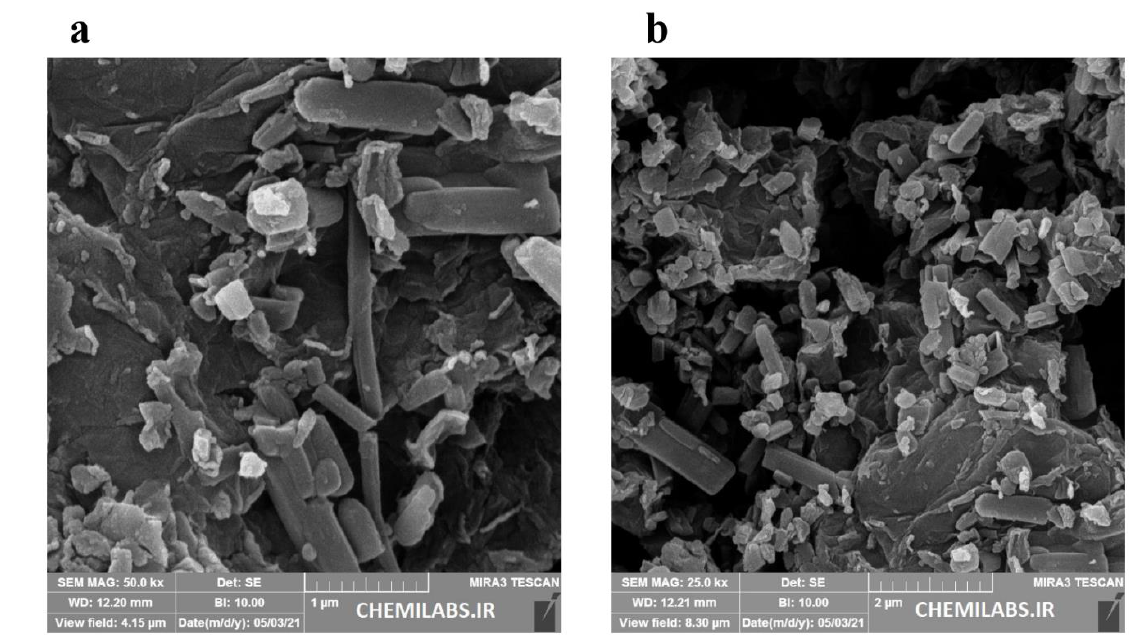
Figure 4. ( a ) EDS spectrum and ( b ) the corresponding elemental mapping images of Co, C, and O elements in the CoMOF sample.